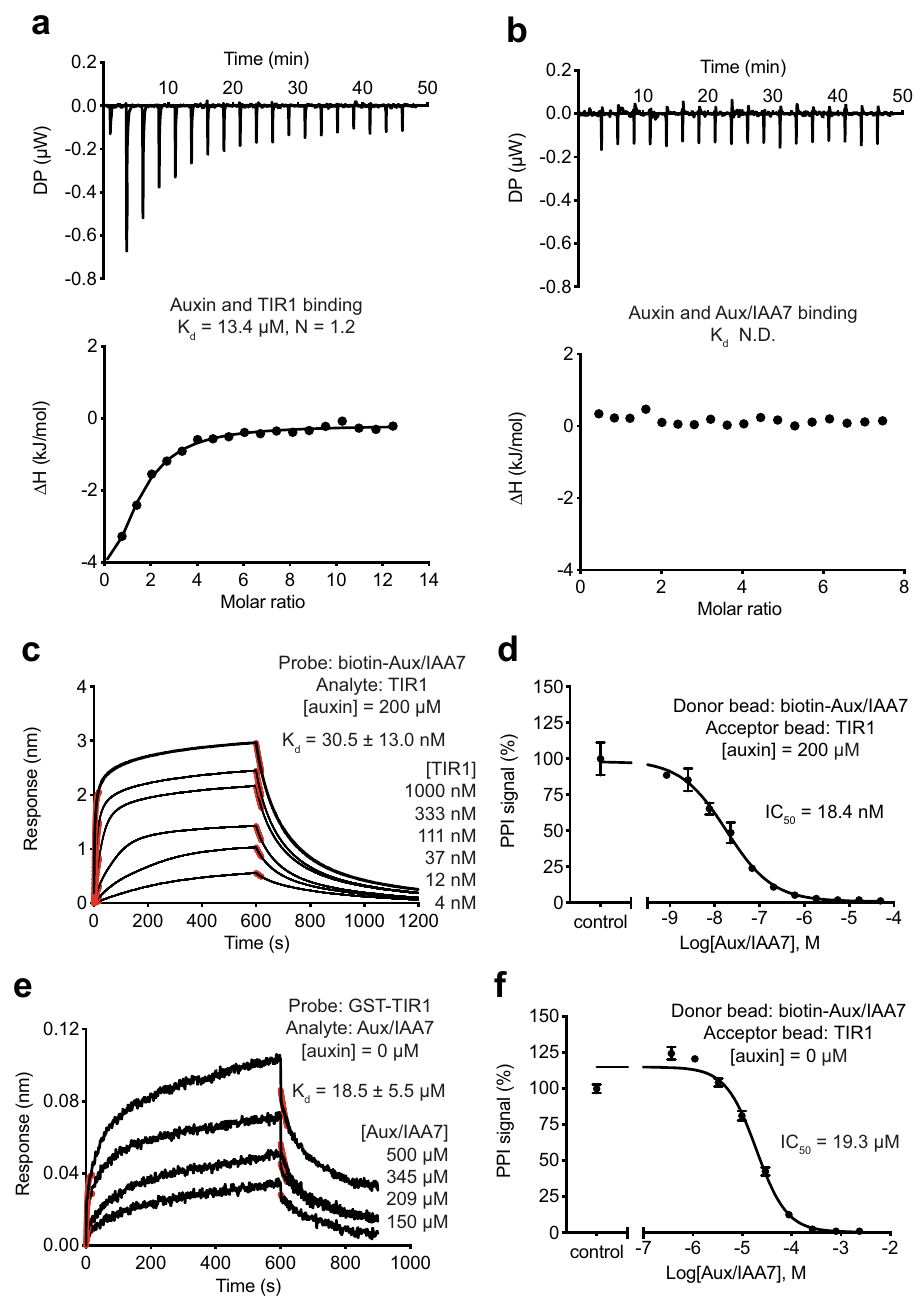
Fig. 5 Quantitative analysis of the auxin-sensing system. a , b Auxin binding to TIR1 and Aux/IAA7 peptide measured by ITC experiments. ND not detected. Source data are provided as a Source Data fi le. c , d BLI and AlphaScreen competition assays for assessing the af fi nity of Aux/IAA7 to TIR1 in the presence of auxin at a saturating concentration. Red lines represent curve fi tting at the initial phase of association and dissociation. K d , dissociation constant. IC 50 , half-maximum inhibitory concentration. Data were presented as mean ± s.d. of n = 3 biologically independent samples. Source data are provided as a Source Data fi le. e , f BLI and AlphaScreen competition assays for assessing the intrinsic af fi nity of Aux/IAA7 to TIR1. Red lines represent curve fi tting at the initial phase of association and dissociation. K d , dissociation constant. IC 50 , half-maximum inhibitory concentration. Data were presented as mean ± s.d. of n = 4 biologically independent samples. Source data are provided as a Source Data fi